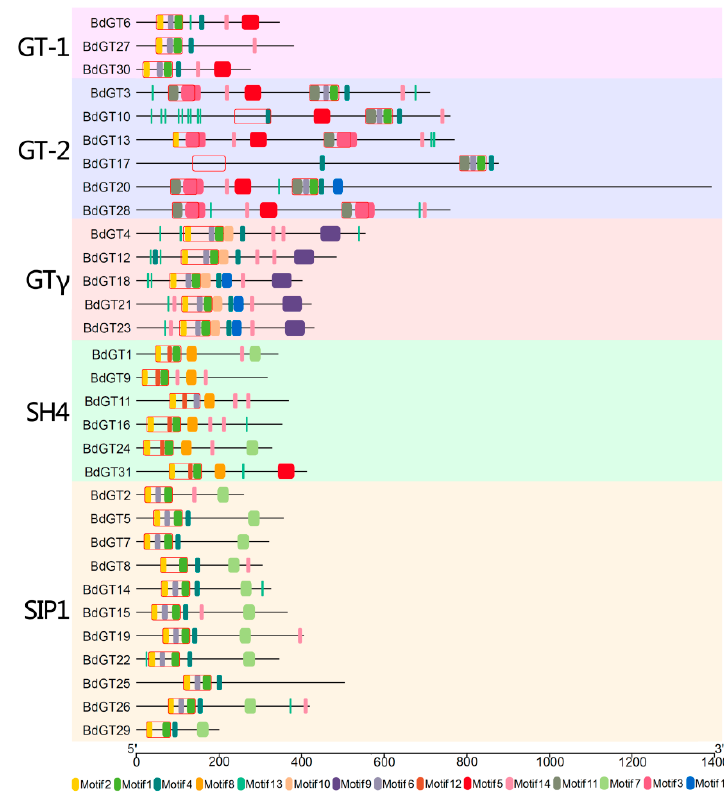
Figure 3. Protein structures of BdGTs in B. distachyon . Each different motif is represented by a specific color, and the conserved GT domain is represented by the red box.